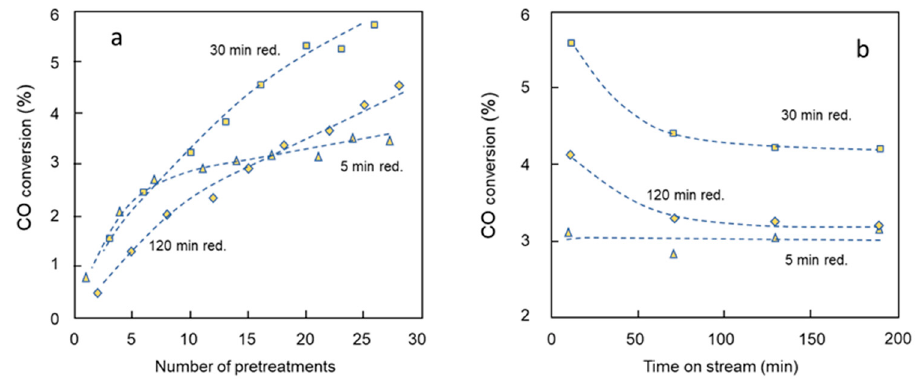
Figure 5. ( a ) CO conversion as a function of pretreatments on one fresh Co foil run continuously in the sequence of 5, 120, and 30 min. ( b ) CO conversion as a function of accumulated TOS under Fischer–Tropsch synthesis for each applied reduction time. Conditions: T = 220 °C; P = 1 bar; H 2 /CO= 3; total flow = 3 Nml/min; TOS for each FT-synthesis: 10 min.